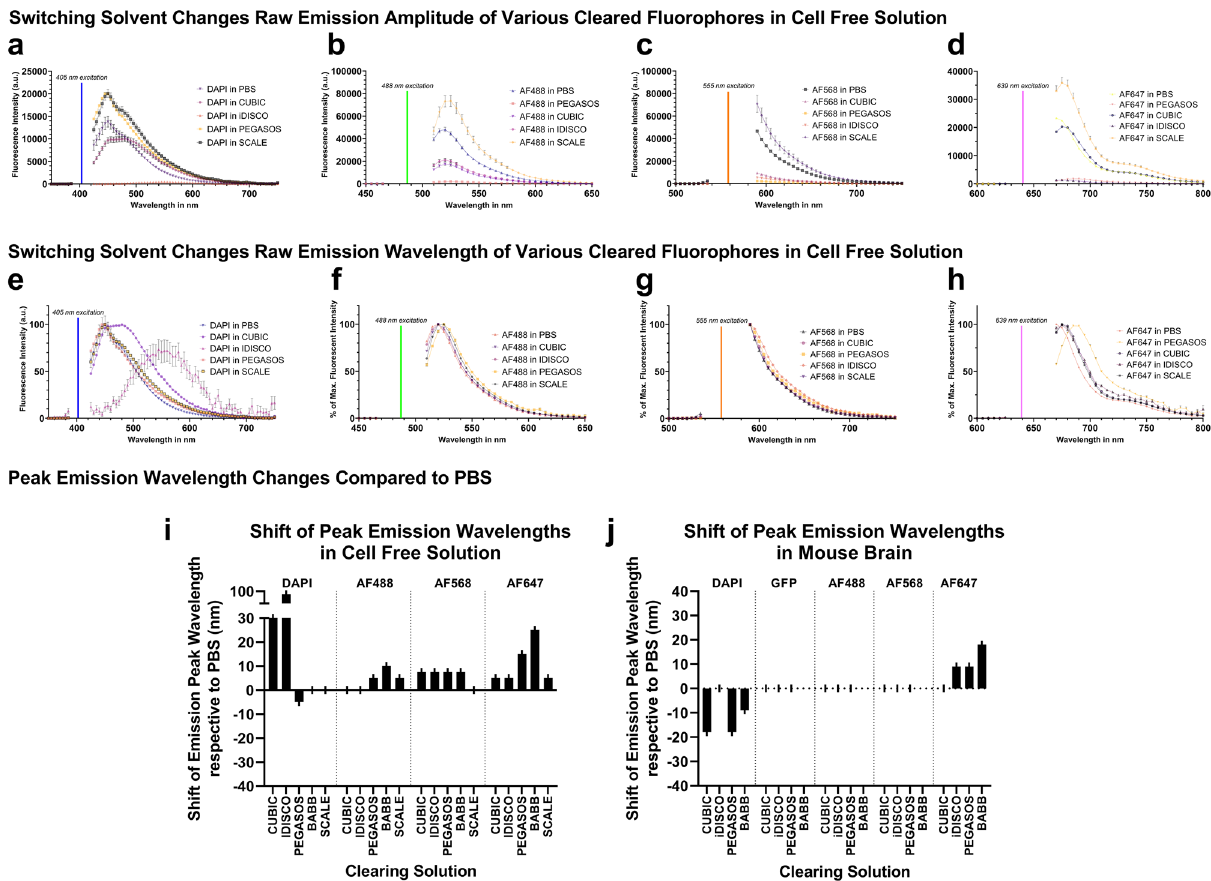
Figure 5. iDISCO, CUBIC, SCALE, and PEGASOS clearing alter the fluorescent emission spectra of fluorophores and fluorescent dyes in cell-free solutions. Raw plate reader-based emission spectra visualize the differences in the amplitude between measurements in PBS and iDISCO, CUBIC, SCALE, and PEGASOS clearing ( a – d ). Emission data normalized to their peak intensity highlight the shift of the emission peaks to altered wavelengths ( e – h ). Bar graphs summarize the direction and magnitude of emission peak wavelength shifts per fluorophore and clearing agent in cell-free solutions ( i ) and in mouse brain tissue ( j ). Bar graphs visualize the shifts depicted in Figs. 4 and 5 and represent the shifts of average emission curves generated from at least n = 8 independent measurements and wells per datapoint. DAPI was excited at 405 nm ( a,e ), Alexa Fluor 488 at 488 nm ( b,f ), Alexa Fluor 568 at 555 nm ( c,g ), and Alexa Fluor 647 at 639 nm ( d,h ). The gaps in spectra surrounding the excitation wavelength are due to technical limitations in the plate reader (see “Methods” section). Error bars indicate standard deviation. n = 8 independent wells for each